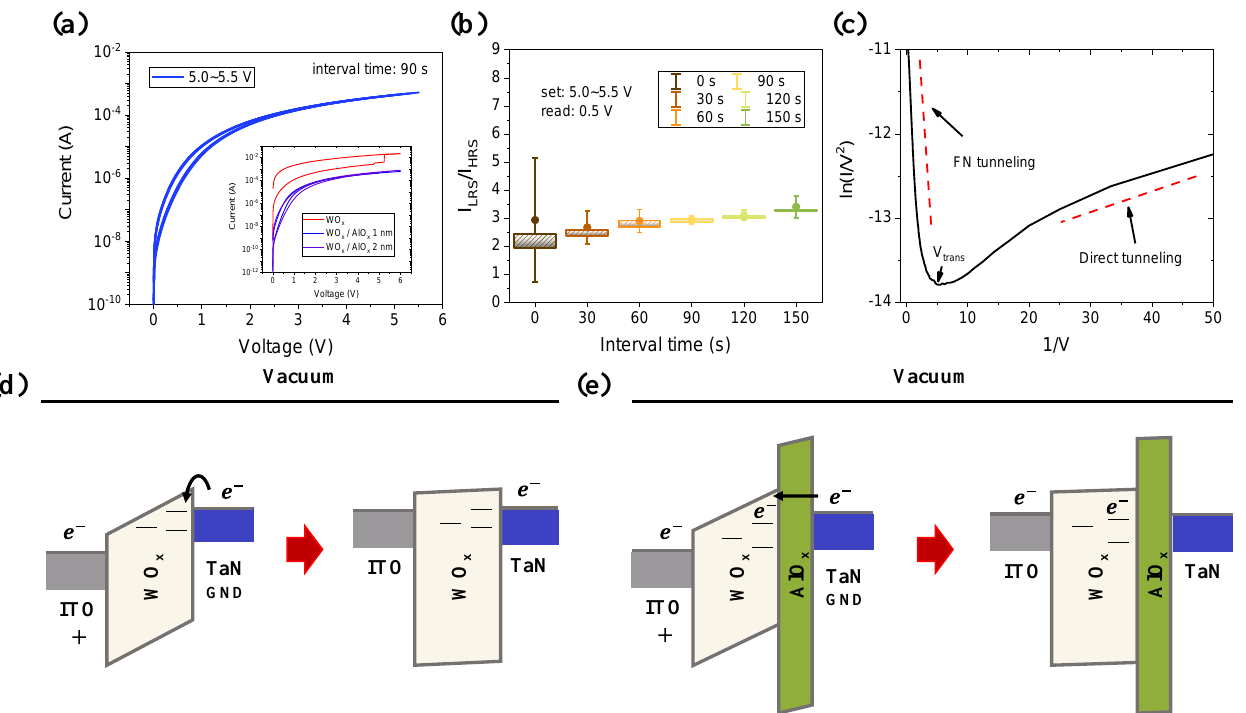
Figure 3. ( a ) The I-V curve for set switching before forming process. Inserted figure shows how each device (AlO x : 0, 1, 2 nm) operates in a small positive bias. ( b ) Before forming device 2, plotting the current ratio of LRS/HRS with interval time. The interval time is the delay time from set to set. Device 2 works by tunneling effect since the ultra-thin AlO x layer is high-k dielectric. ( c ) The Fowler – Nordheim tunneling and direct tunneling plot of device 2. ( d ) The energy band model of device 1 and ( e ) device 2 for set switching.